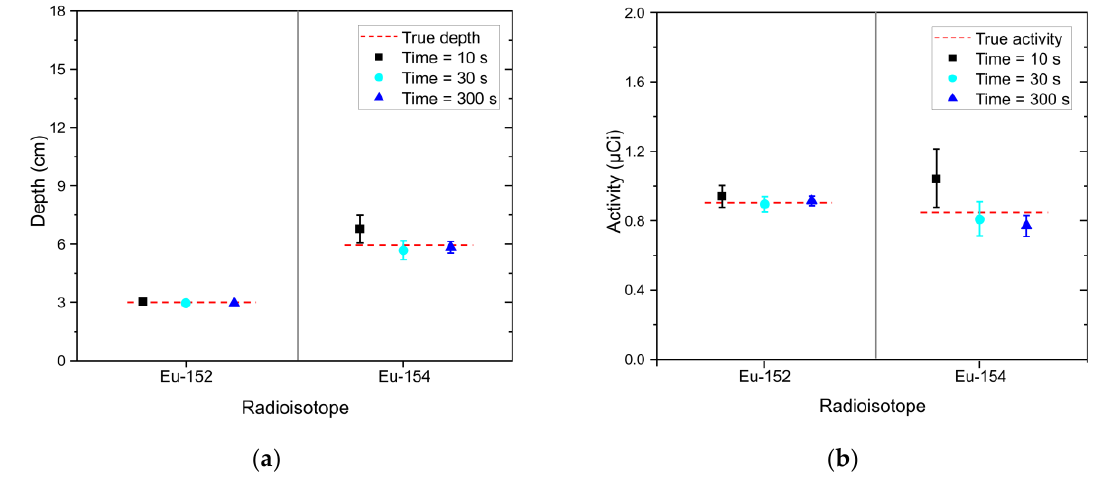
Figure 9. ( a ) Estimated depth and ( b ) activity of identified radioisotopes (i.e., Eu-152 and Eu-154) in the form of mean and 1.96 standard error analyzed for experimental spectra with acquisition times of 10 s (black square), 30 s (sky-blue circle), and 300 s (blue triangle). The spectra were acquired with Eu-152 and Eu-154 sources buried in sand at depths of 3 cm and 6 cm, respectively.